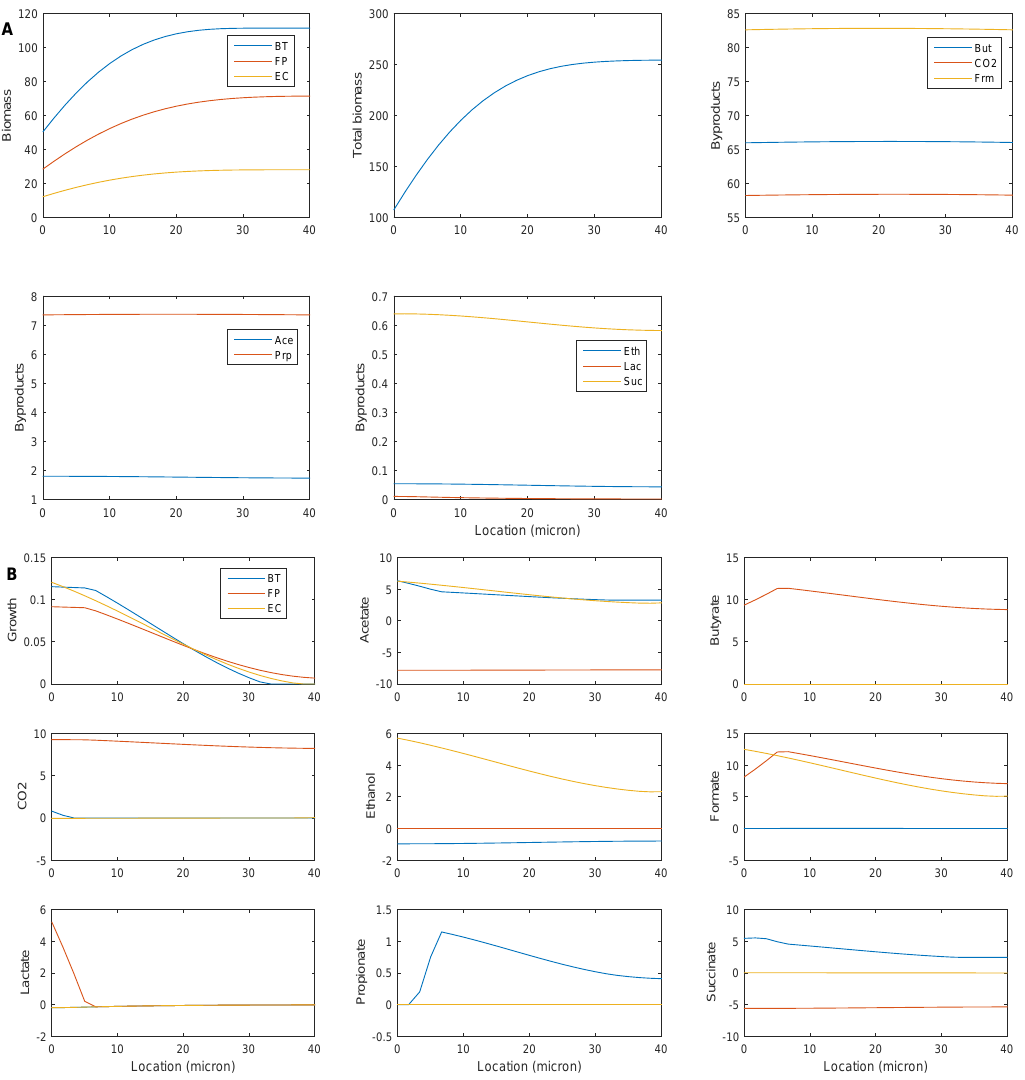
Figure 5. Steady-state spatial profiles predicted by the multispecies biofilm model with reduced E. coli ATP maintenance. ( A ) Biomass and byproduct concentrations. Units are g/L for biomass and mmol/L for the byproducts; ( B ) Species growth rates and byproduct uptake and secretion rates. Units are h − 1 for growth rates and mmol/gDW/h for the other